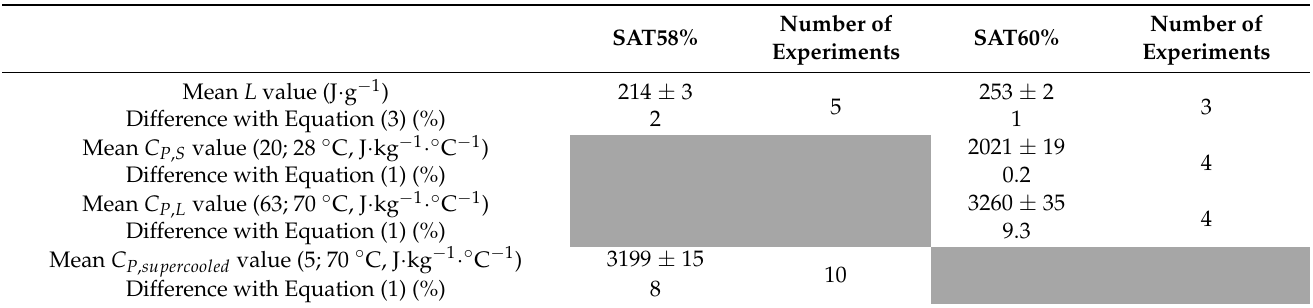
Table 2. Initial properties of the sample before aging.